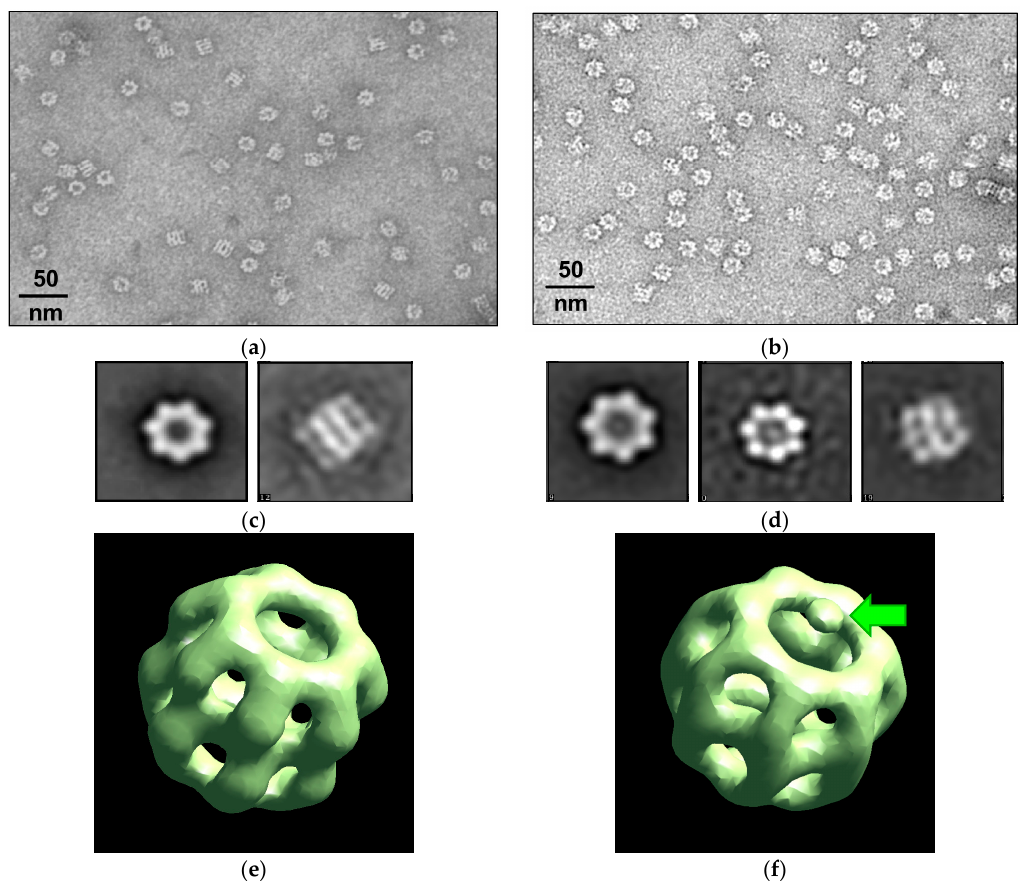
Figure 4. The reconstruction of the GroEL 14 and GroEL 14 -EGFP spatial structures using their TEM images: the field and identified averaged top and side views of GroEL 14 ( a , c ) and GroEL 14 -EGFP ( b , d ); the respective reconstructions ( e , f ). The green arrow indicates the center of the EGFP position in the reconstruction.